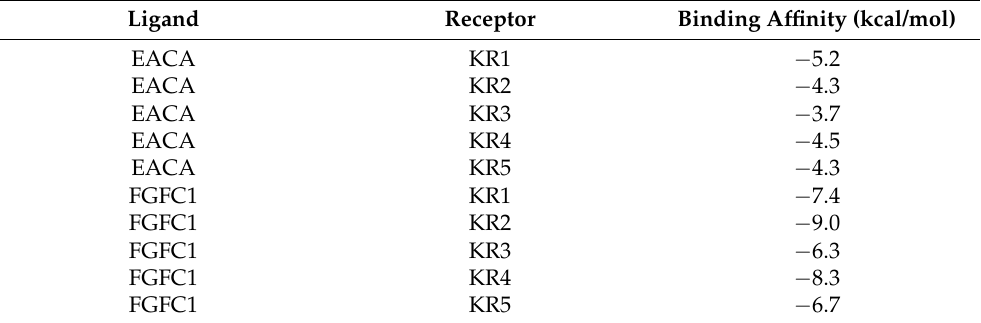
Table 3. The binding affinity values of the most appropriate binding modes obtained from AutoDock.